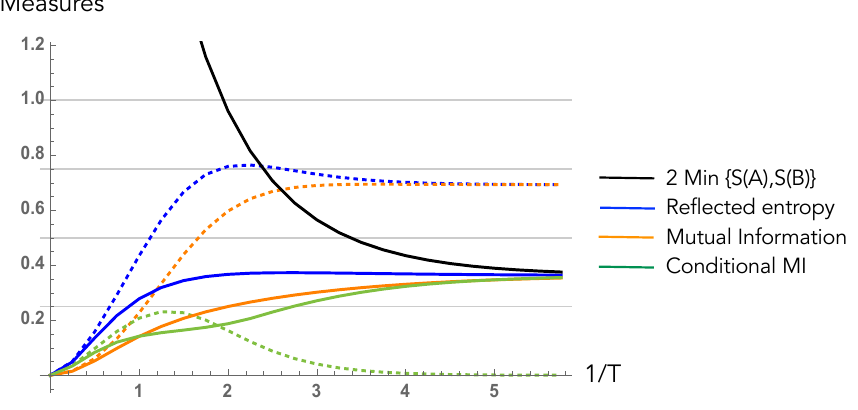
Figure 11 . For the Ising model with N = 8 , the temperature dependence of the reflected entropy (blue) is shown, in comparison to the mutual information (orange) and the conditional mutual information (green). We consider g = 0 . 01 and g = 2 , shown by dots and solid respectively.